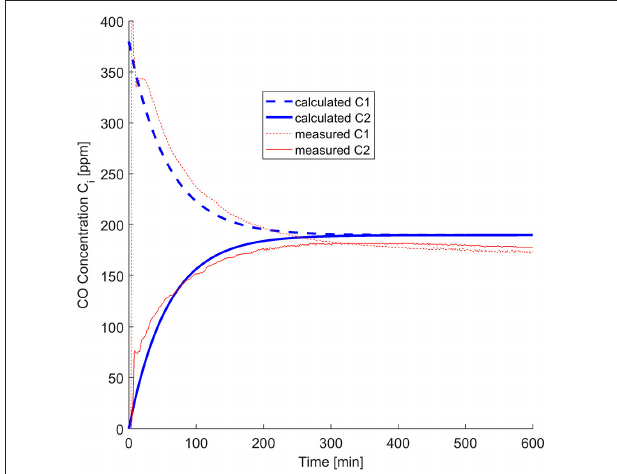
FIGURE 5 | Comparison between the experimental results and the calculated diffusivity for experimental data using 0.5 ′′ gypsum wallboard.